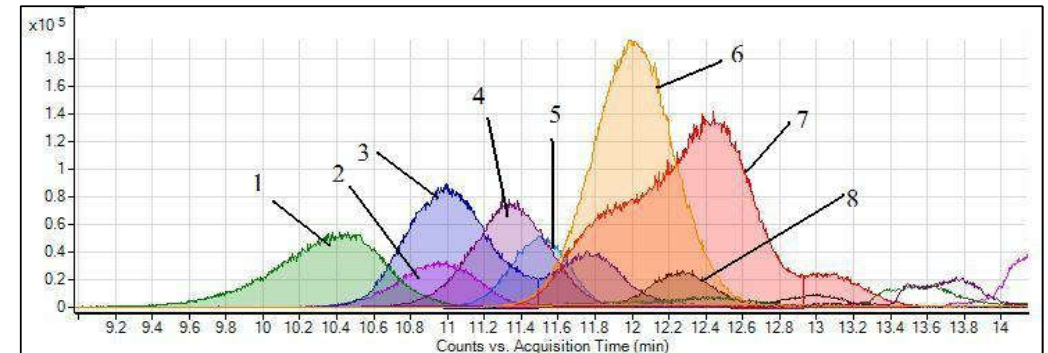
Figure 1. Overlay of [M + H] + ions of major anthocyanins in raw berry sample. ( 1 ) Delphinidin-3- pyrannoside ( m / z 465 [M + H] + ); ( 2 ) Delphinidin-3-arabinoside ( m / z 435 [M + H] + ); ( 3 ) Cyanidin-3- pyrannoside ( m / z 449 [M + H] + ); ( 4 ) Petunidin-3-pyrannoside ( m / z 479 [M + H] + ); ( 5 ) Cyanidin-3- arabinoside ( m / z 419 [M + H] + ); ( 6 ) Malvidin-3-pyrannoside ( m / z 493 [M + H] + ); ( 7 )